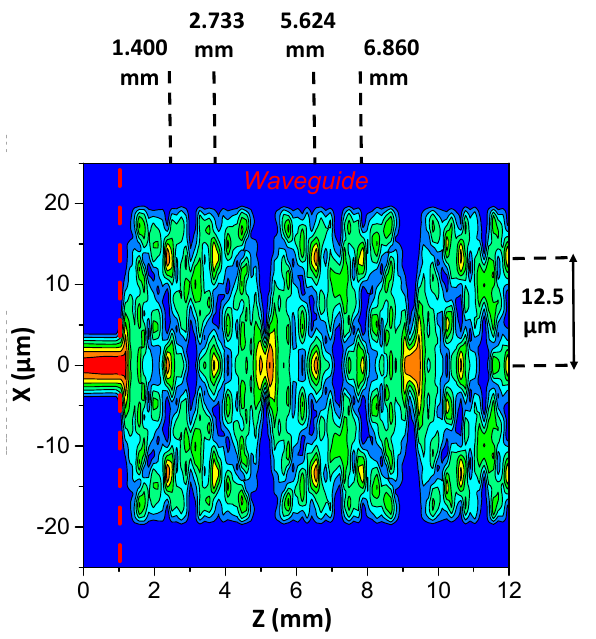
Figure 6. BPM simulation (at 600 nm) of the light field propagation along a strongly multi-mode waveguide (width: 40 µm) in the XZ-plane. Self-imaging can be observed for one or three images at periodic intervals along the Z-axis. The waveguide is excited by an SMF28 optical fiber (left) through a butt-coupling configuration.